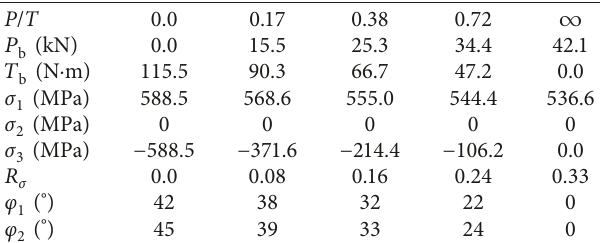
Figure 5: SEM images of fracture surfaces for QT400 nodular cast iron in combined tension-torsion tests with different tension-torsion ratios on the fracture surface of the specimen with tension-torsion ratio (a) P/T � 0.0, (b) P/T � 0.17, (c) P/T � 0.38, and (d) P/T � 0.72. Table 1: The experimental data points of QT400-15 nodular cast iron in combined tension-torsion tests.